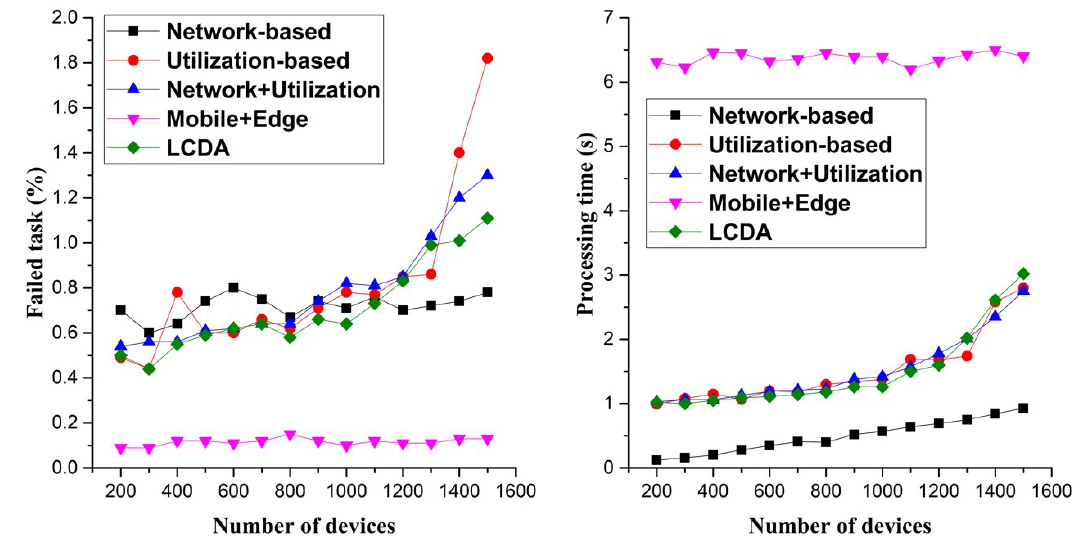
Figure 4. Scalability based on the number of users (devices). LCDA stands for latency classification deadline aware task offloading algorithm.